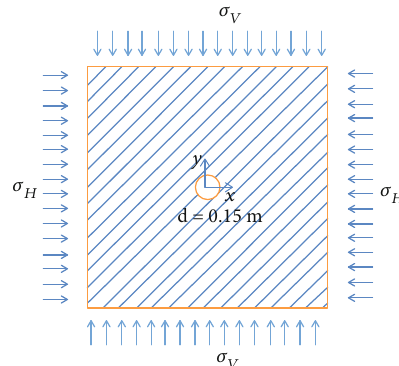
Figure 2: Schematic diagram of the stress state of a horizontal